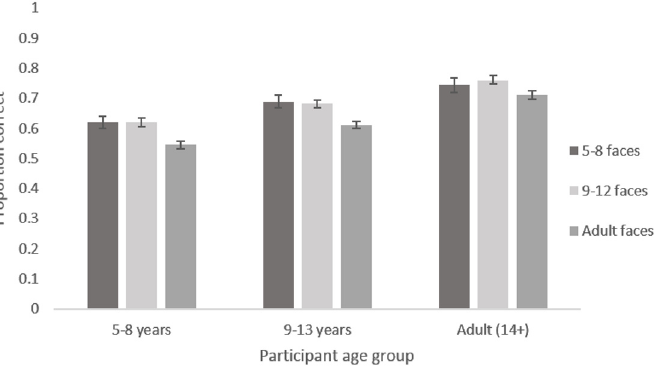
Fig 6. Mean proportion of correct responses to images from each age face set by each participant age group. Error bars show standard error.